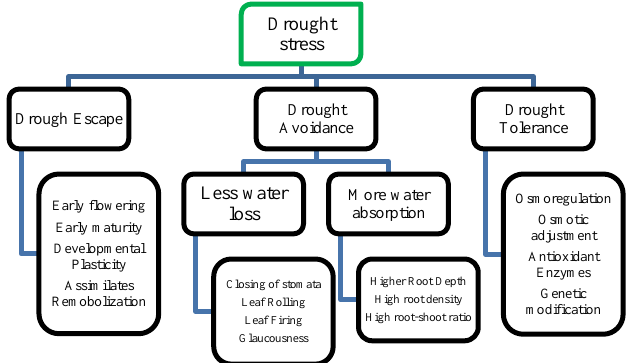
Figure 4: Resistance mechanism of Drought